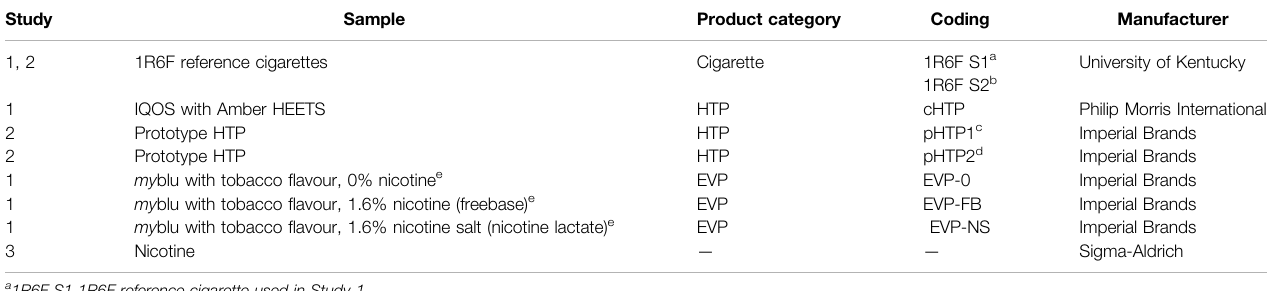
TABLE 1 | Test samples evaluated in the Cardio qP assay.